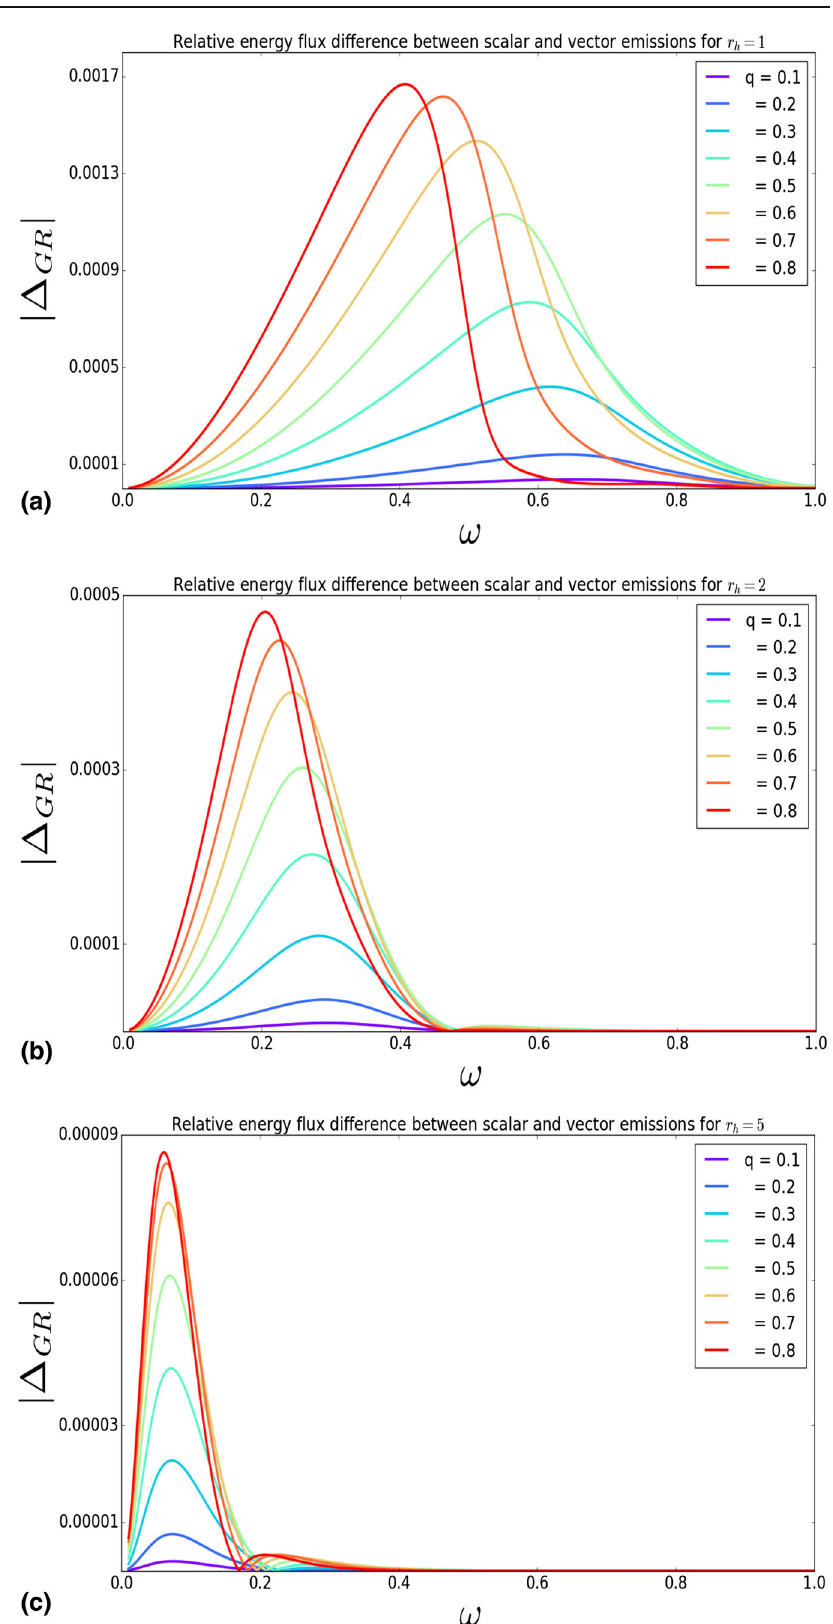
Fig. 1 Relative energy flux difference (cid:15) GR for three different horizon radii. Increasing BH size leads to larger characteristic length scales for the space-time leading to the shift of the profiles towards low